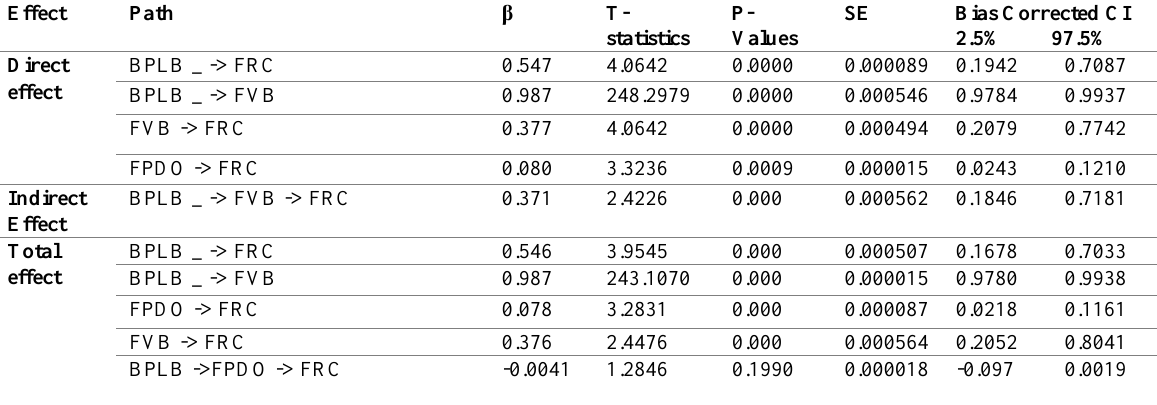
Table 4: Path analysis of Followers Radical Creativity